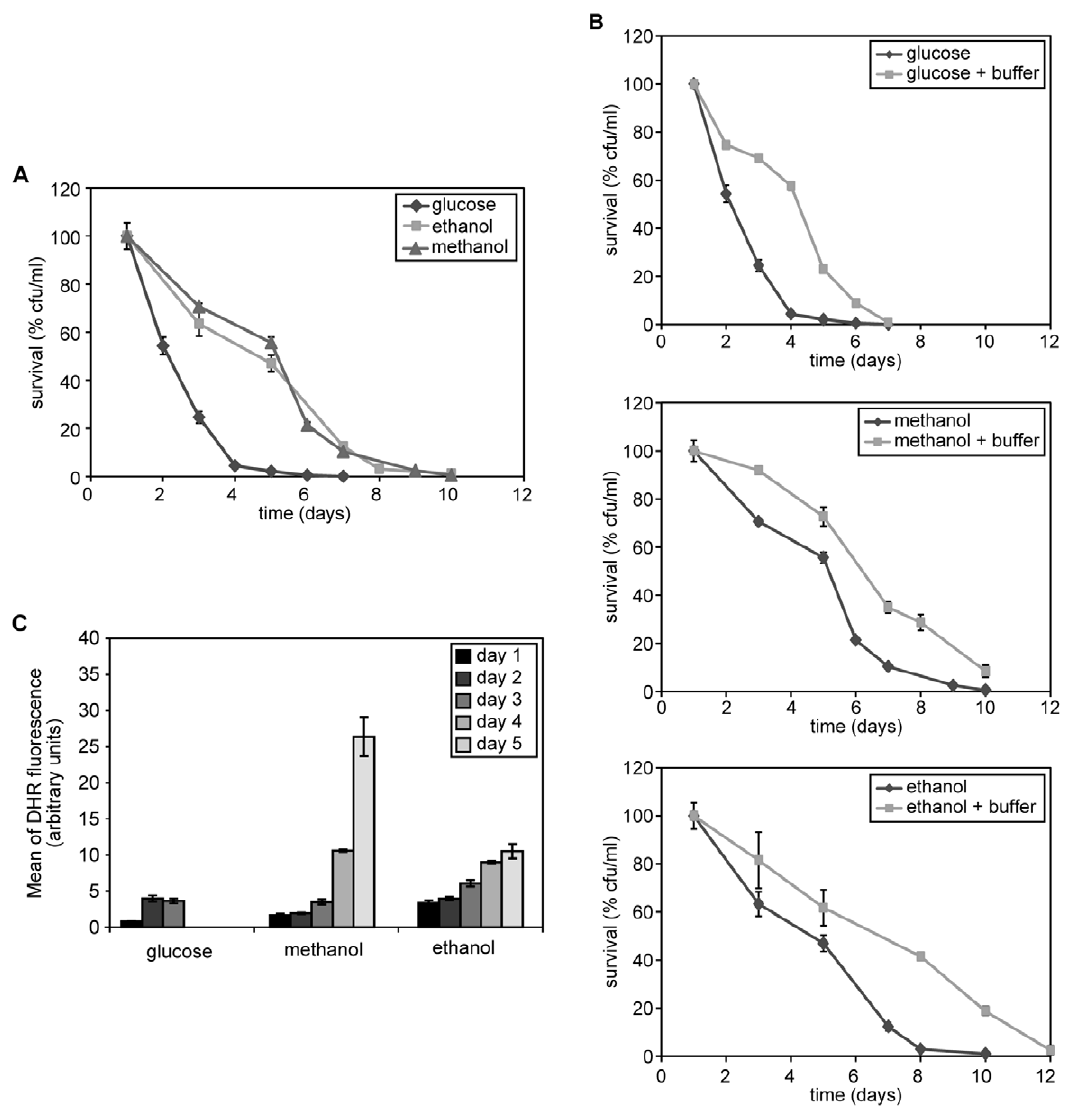
Figure 1. Chronological aging of H.polymorpha cells grown on different carbon sources. (A) CLS of wild-type cells following cultivation on various carbon sources (0.5% glucose, 0.35% ethanol or 0.5% methanol) in the presence of ammonium sulfate (AS) as nitrogen source. (B) CLS cultures grown like for panel A, but shifted to phosphate buffer pH 6 after reaching the stationary phase (16 h for glucose and 40 h for ethanol and methanol). (C) Measurement of DHR fluorescence in wild-type cells grown on different carbon sources as indicated in Figure 1A. Bars indicate the standard error of mean. The lifespan curves shown represent the average of 4–6 experiments.